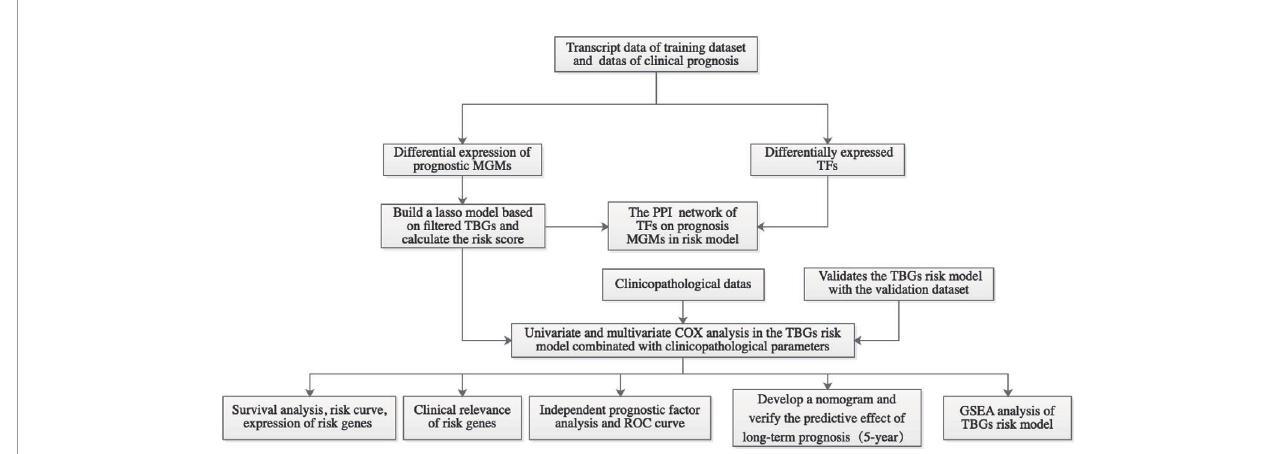
FIGURE 1 | Work fl ow graph for this study. MGMs, marker genes of macrophage; TBGs, TAM-based ten-gene signatures; TFs, transcription factors; PPI, protein – protein interaction; ROC, receiver operating characteristic; GSEA, gene set enrichment